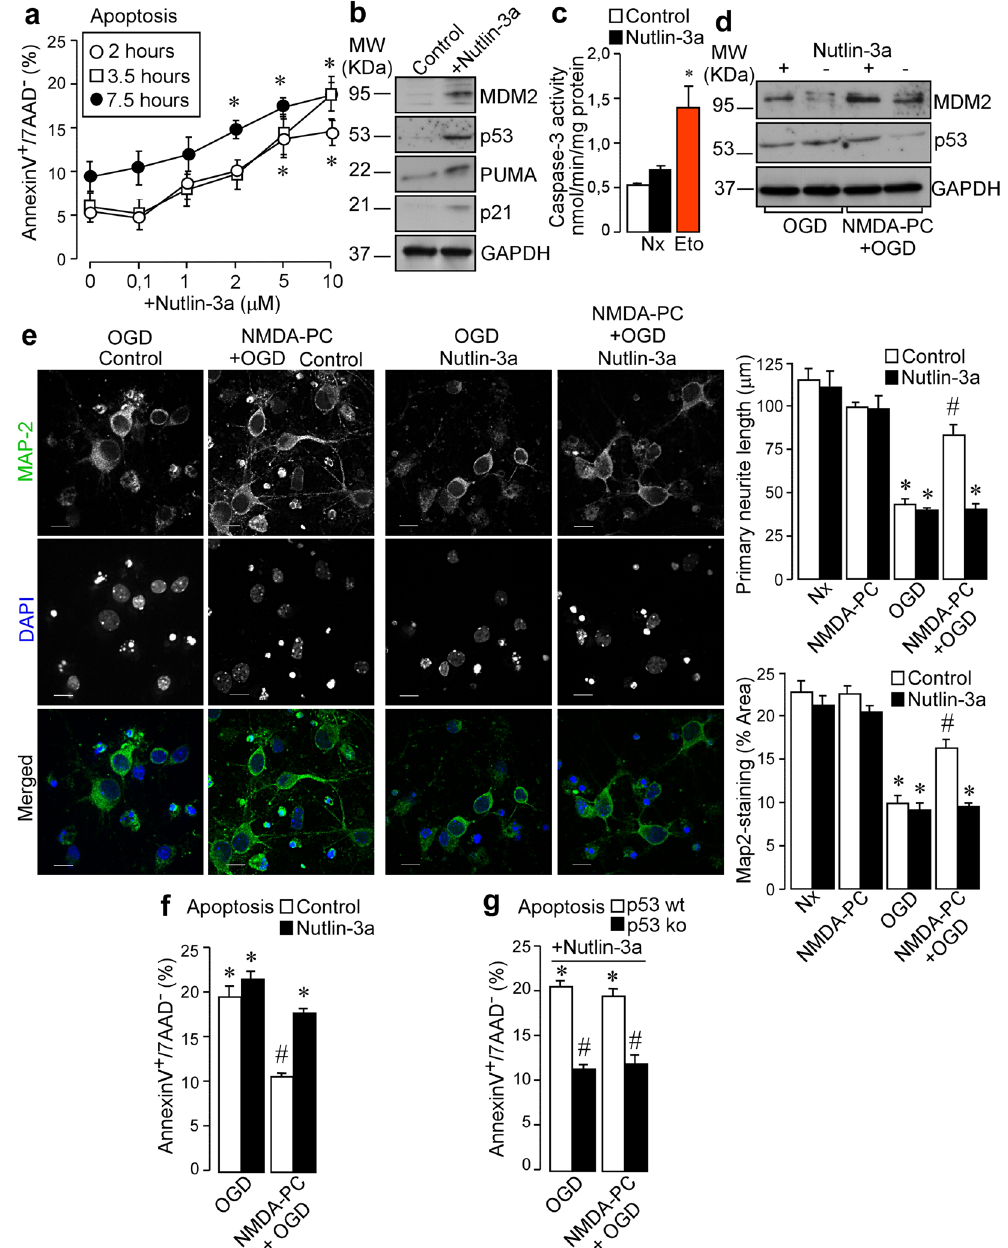
Figure 6. Pharmacological disruption of MDM2-p53 interaction abrogates NMDA-PC-caused neuroprotection after ischemia. Neurons (9–10 DIV) were treated with different concentrations of nutlin-3a (0–10 μ M), a potent an specific inhibitor of MDM2 activity, at time periods indicated. ( a ) Nutlin-3a induced a dose-time dependent apoptotic effect in neurons, as compared with untreated neurons. The percentage of annexin V-APC stained neurons that were 7AAD negative were considered to be apoptotic (AnnexinV + /7AAD − ). ( b ) As revealed by western blot, treatment with 2 μ M nutlin-3a for 2 hours under normoxic conditions (indicated as control) increased MDM2, p53, p21 and PUMA expression levels. A representative western blot image is shown out of three. ( c ) Nutlin-3a-induced p53 stabilization did not cause the activation of caspase-3, when compared with neurons treated with the inductor of apoptosis, etoposide (10 μ M, 24 hours; in red). ( d ) Disruption of MDM2-p53 interaction induced by nutlin-3a treatment prevented p53 destabilization caused by NMDA-PC. ( e ) Fluorescence microphotographs of neurons after immunostaining for Map-2 (green) revealed that nutlin-3a abrogates NMDA-PC-induced p53 destabilization and promotes neurite degeneration, as judged by quantification of the average primary neurite length and Map-2-staining area, at 4 hours after OGD. Scale bar: 10 μ m. ( f ) MDM2-p53 disruption abrogated NMDA-PC-induced neuroprotection at 4 hours after OGD in wt neurons, ( g ) but not in p53 ko neurons. Data are means ± S.E.M. Statistical analysis of the results was evaluated by one-way analysis of variance, followed by the least significant difference multiple range test. Student’s t-test was used for comparisons between two groups of values. In all cases, p < 0.05 was considered significant. In ( a